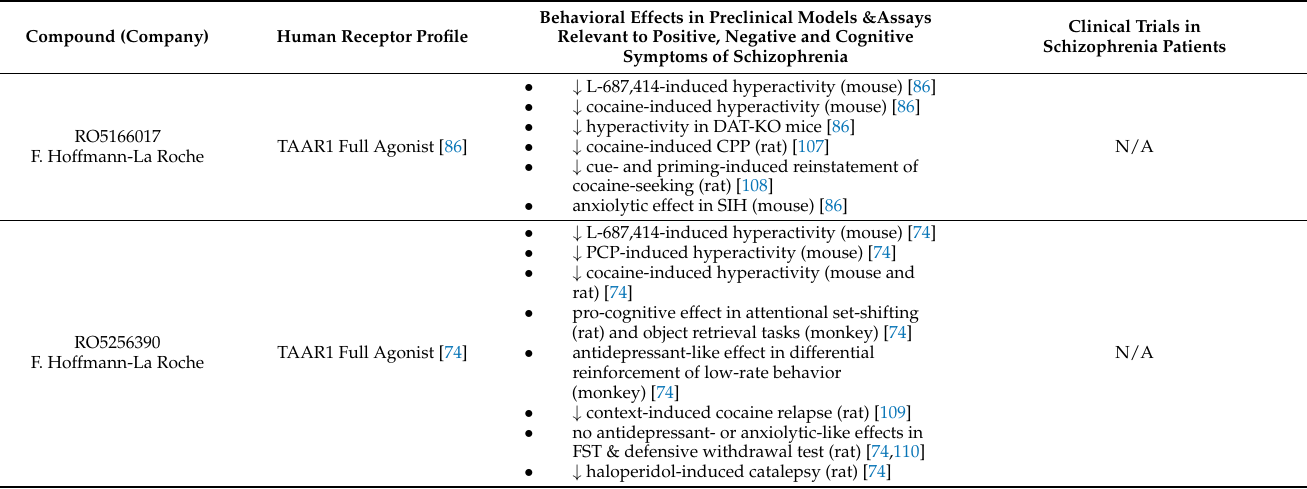
Figure 2. TAAR1-mediated modulation of monoaminergic and glutamatergic circuits. Simplified schematic of key serotonergic, dopaminergic, and glutamatergic pathways in the rodent brain including evidence from studies with synthetic ligands and TAAR1-KO mice. ↑ , increase; ↓ , decrease; ( − ), no change. Abbreviations: 5-HT (serotonin), AMPH (amphetamine), Amy (amygdala), dSTR (dorsal striatum/caudoputamen), DA (dopamine), Hip (hippocampus), LC (locus ceruleus), m (mouse), MDMA (3,4-Methylenedioxymethamphetamine), NA (noradrenalin), NAc (nucleus accumbens), PFC (prefrontal cortex), r (rat), SN (substantia nigra), VTA (ventral tegmental area). Table 2. Pharmacological effects of TAAR1 agonists in preclinical